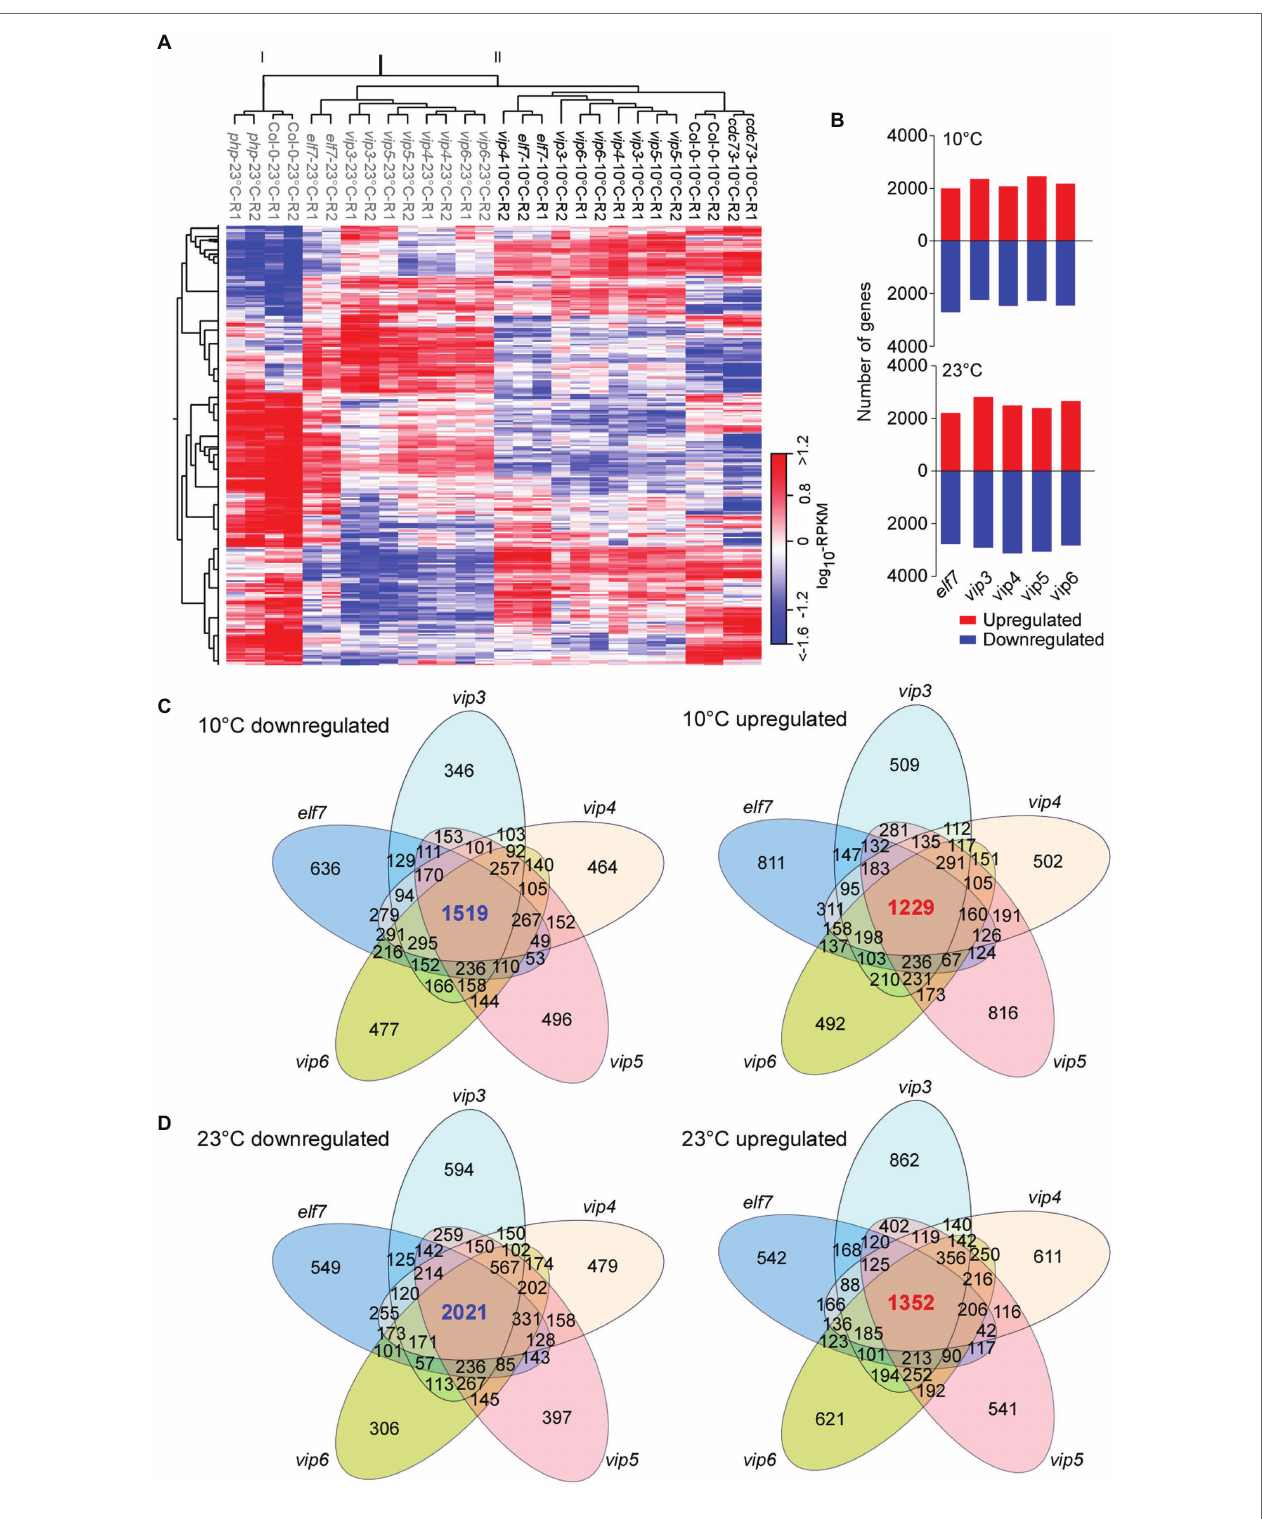
FIGURE 2 | Transcriptome analyses of PAF1C-deficient mutants. (A) Heatmap showing the global expression differences between the wild type (Col-0) and PAF1C-deficient mutants. The genotypes of plants grown at 23 ° C are shown in grey, whereas plants grown at 10 ° C are shown in black. (B) Differentially expressed genes (DEGs) in PAF1C-deficient mutants compared to wild-type (Col-0) seedlings at 10 ° C (upper panel) and 23 ° C (lower panel). (C,D) Venn diagrams representing the commonly downregulated and upregulated genes at 10 ° C (C) and 23 ° C (D) in PAF1C-deficient